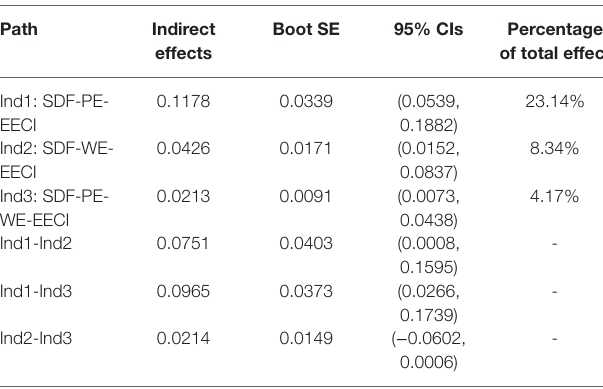
TABLE 5 | Conditional indirect effects of the chained mediation